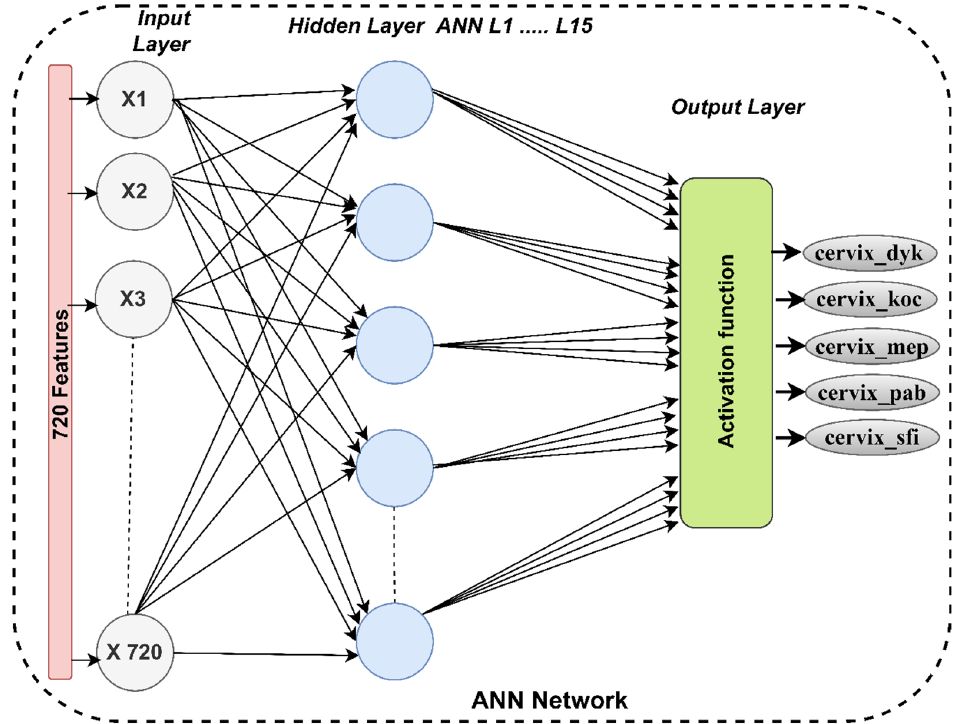
Figure 5. The architecture of the ANN algorithm for classifying cervical cancer data set.